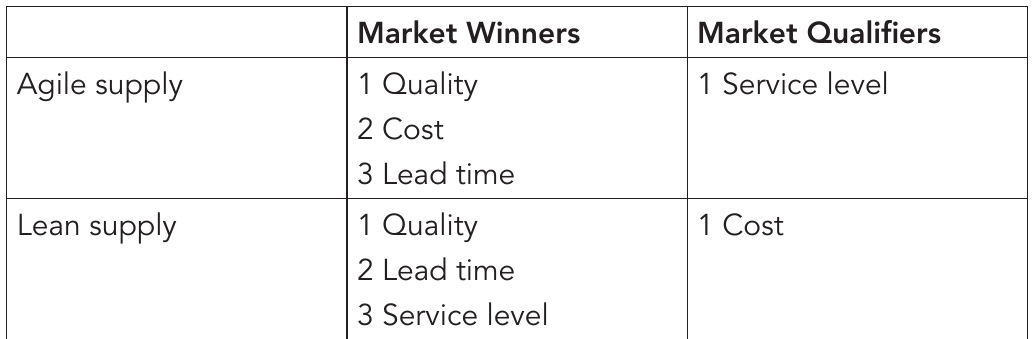
Table 1: Market qualifiers and market